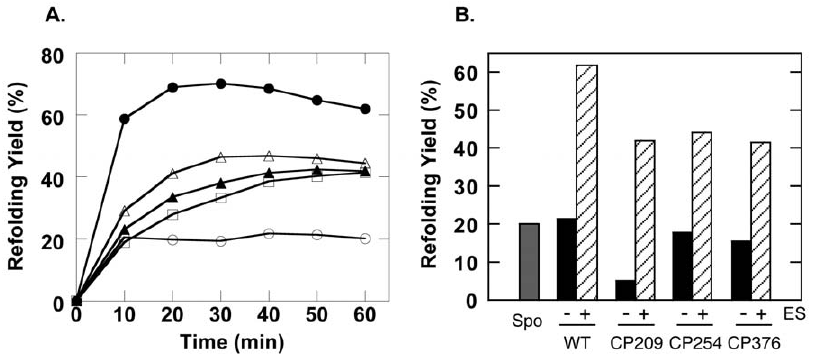
Figure 4. Refolding assays of bovine rhodanese performed under non-permissive conditions at 25 6 C. A. Refolding profiles of rhodanese in the presence of GroES, ATP and wild type/CP GroEL. Open circles indicate spontaneous refolding, closed circles indicate refolding in the presence of wild type GroEL. The other traces were measured in the presence of the following CP mutants: closed triangles , CP209, open triangles , CP254, open squares , CP376. B. The refolding of rhodanese was a GroES-dependent event. Refolding yields after a 60 min incubation at 25 u C are shown. The grey column indicates spontaneous yields, and for each chaperonin, the solid column denotes refolding yields in the absence of GroES and the hatched column indicates yield in the presence of equimolar